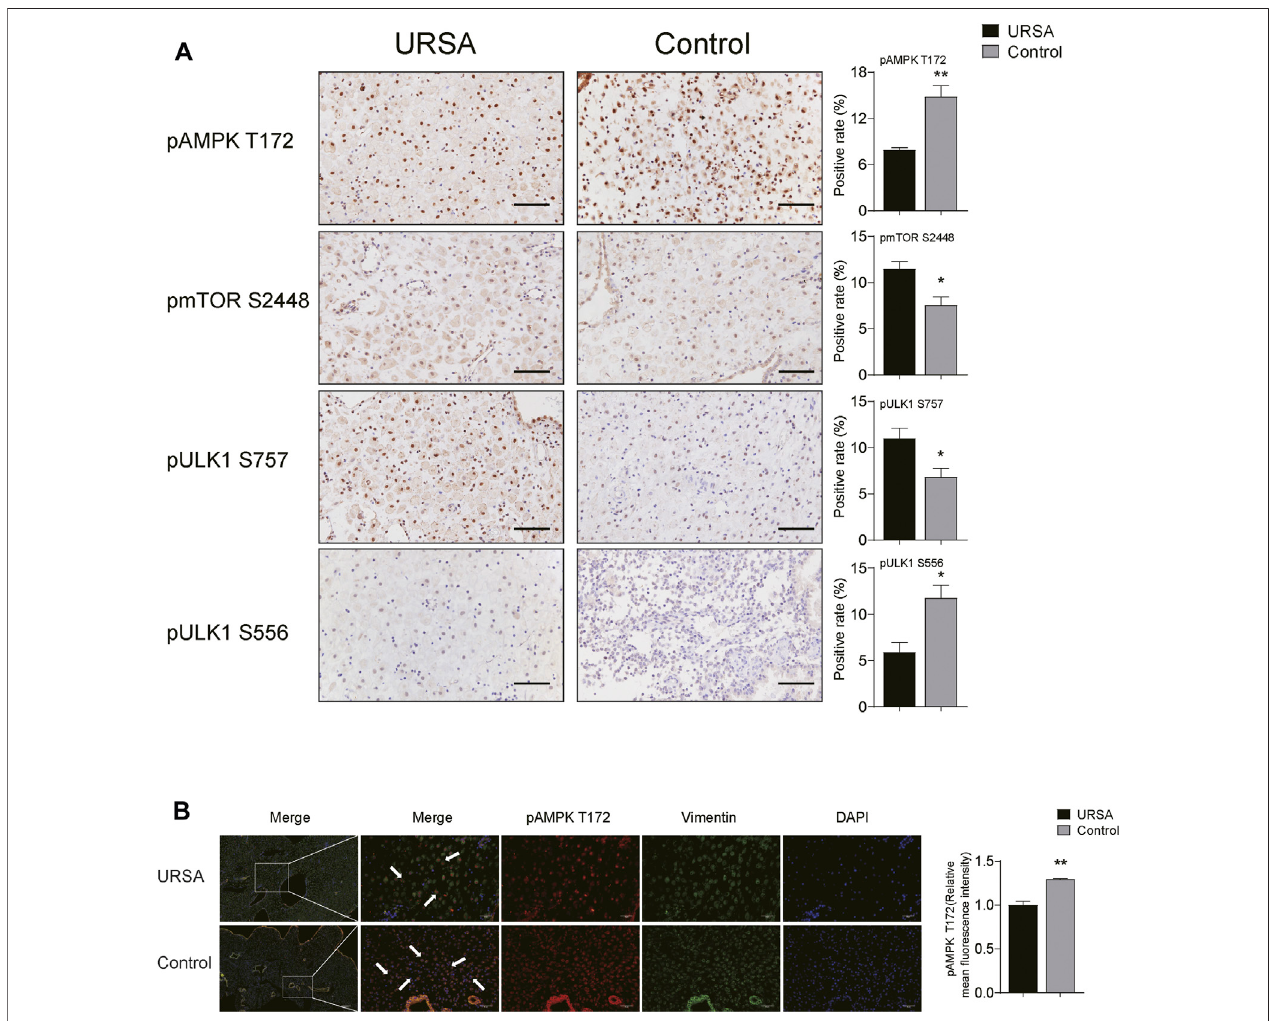
FIGURE 4 | AMPK/mTOR/ULK1 may be associated with the inhibition of autophagy. (A) The expression of pAMPK, pmTOR and pULK1 in decidua tissues of the two groups by immunohistochemistry (scale bar: 50 μ m); (B) Immuno fl uorescence co-location of pAMPK and vimentin, and the expression of pAMPK (scale bar: 200 and 50 μ m). * p < 0.05 vs. URSA group; ** p < 0.01 vs. URSA